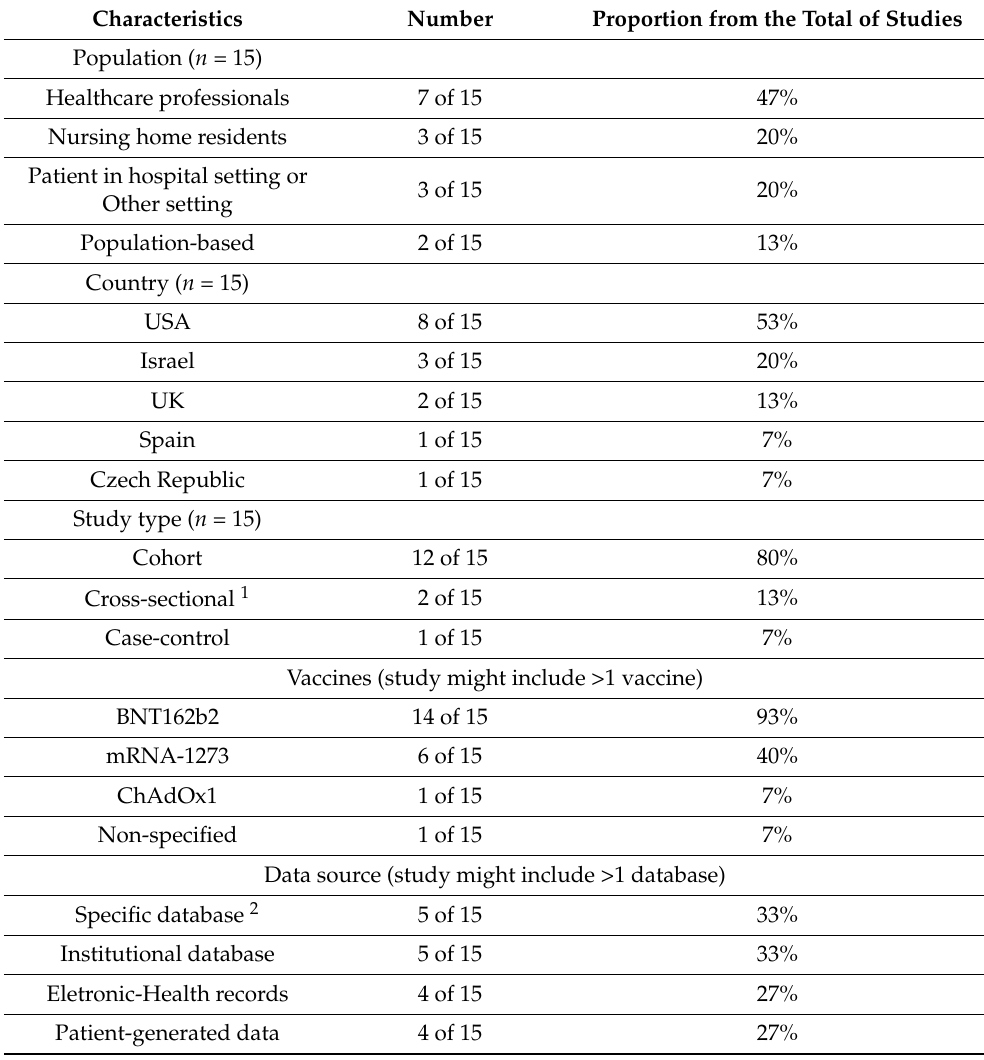
Table 1. General characteristics of studies using real-world data to assess effectiveness or safety in the first 4 months after vaccines’ first